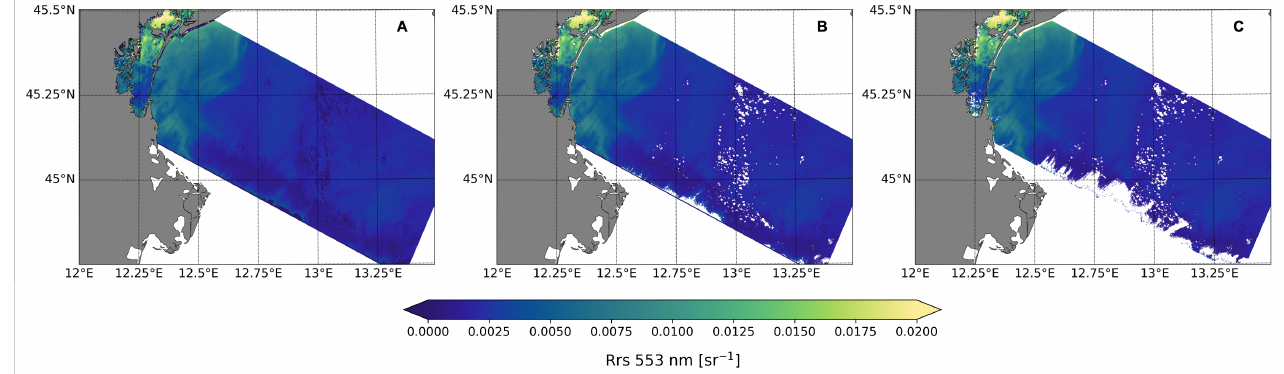
Figure 6. Comparison of the spatial distribution of HICO-Rrs at 553 nm in the northern Adriatic Sea on 26 September 2010: ( A ) no flags; ( B ) recommended flags; and ( C ) recommended flags plus ‘case-2’ and ‘inconsistency’ flags raised